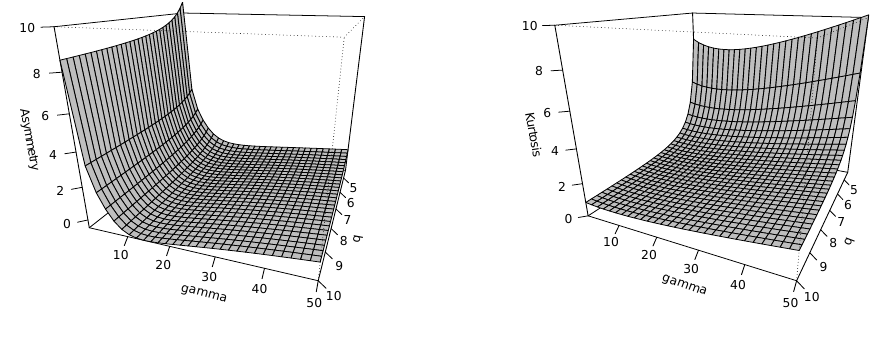
Figure 2. Asymmetry coefficient ( left ) and kurtosis coefficient ( right ) for SPM